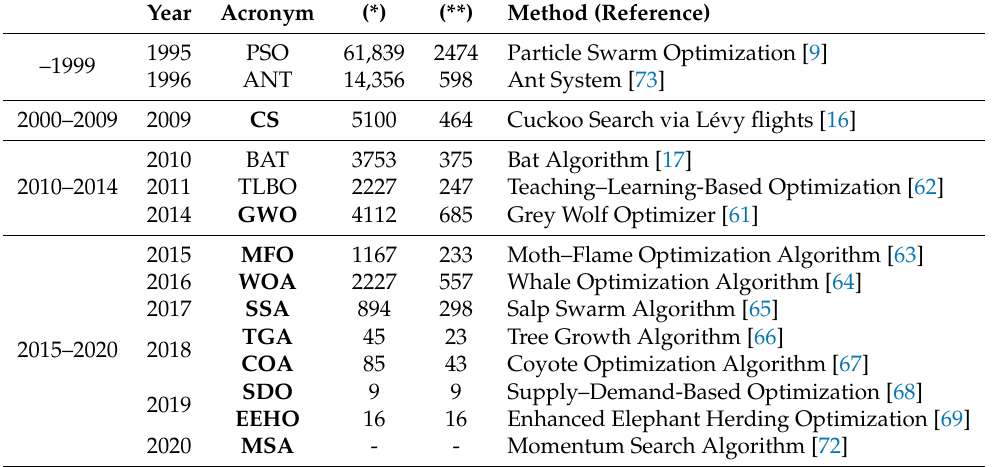
Table 1. Citation metrics of swarm-based